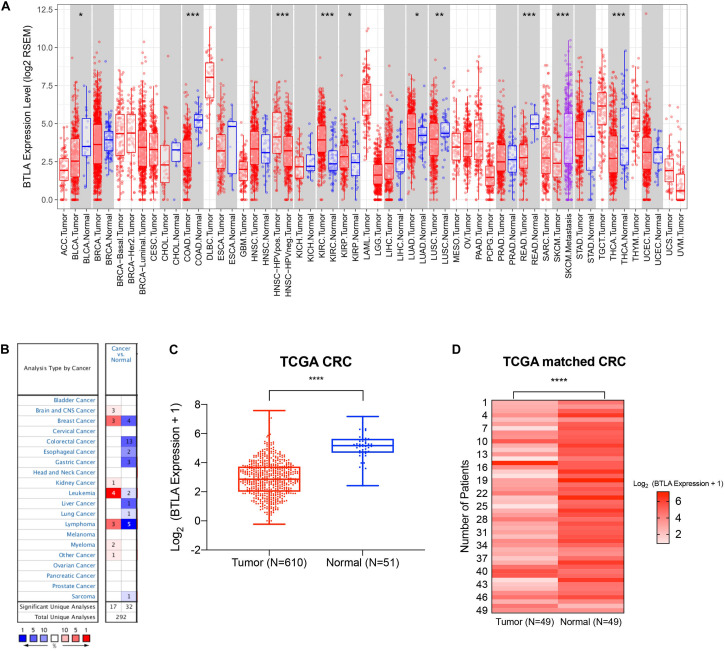
The expression of BTLA in colorectal cancer and other cancer types. (A) BTLA mRNA levels in different cancer types by TIMER database. *p < 0.05, **p < 0.01, ***p < 0.001. (B) BTLA in different cancer data sets increased or decreased compared with normal tissues detected by the Oncomine database. (C) BTLA expression levels in whole tumorous tissues and normal tissues in TCGA cohorts. ****p < 0.0001. (D) BTLA expression levels in tumor tissues and paired normal adjacent tissues in TCGA cohorts.****p < 0.0001.